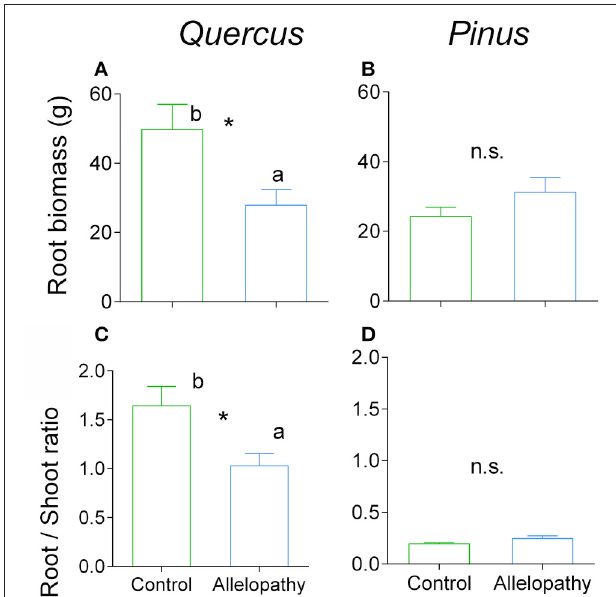
FIGURE 4 | Effects of allelopathic treatment in belowground biomass and allocation. Belowground biomass in Quercus (A) and Pinus (B) and belowground allocation in Quercus (C) and Pinus (D) in Control (green bars) and Allelopathy (blue bars) treatments. Bars are means ± SD ( 5 ≤ n ≤ 8 ). Different letters indicate a significant difference between control and allelopathy treatments at P < 0.05